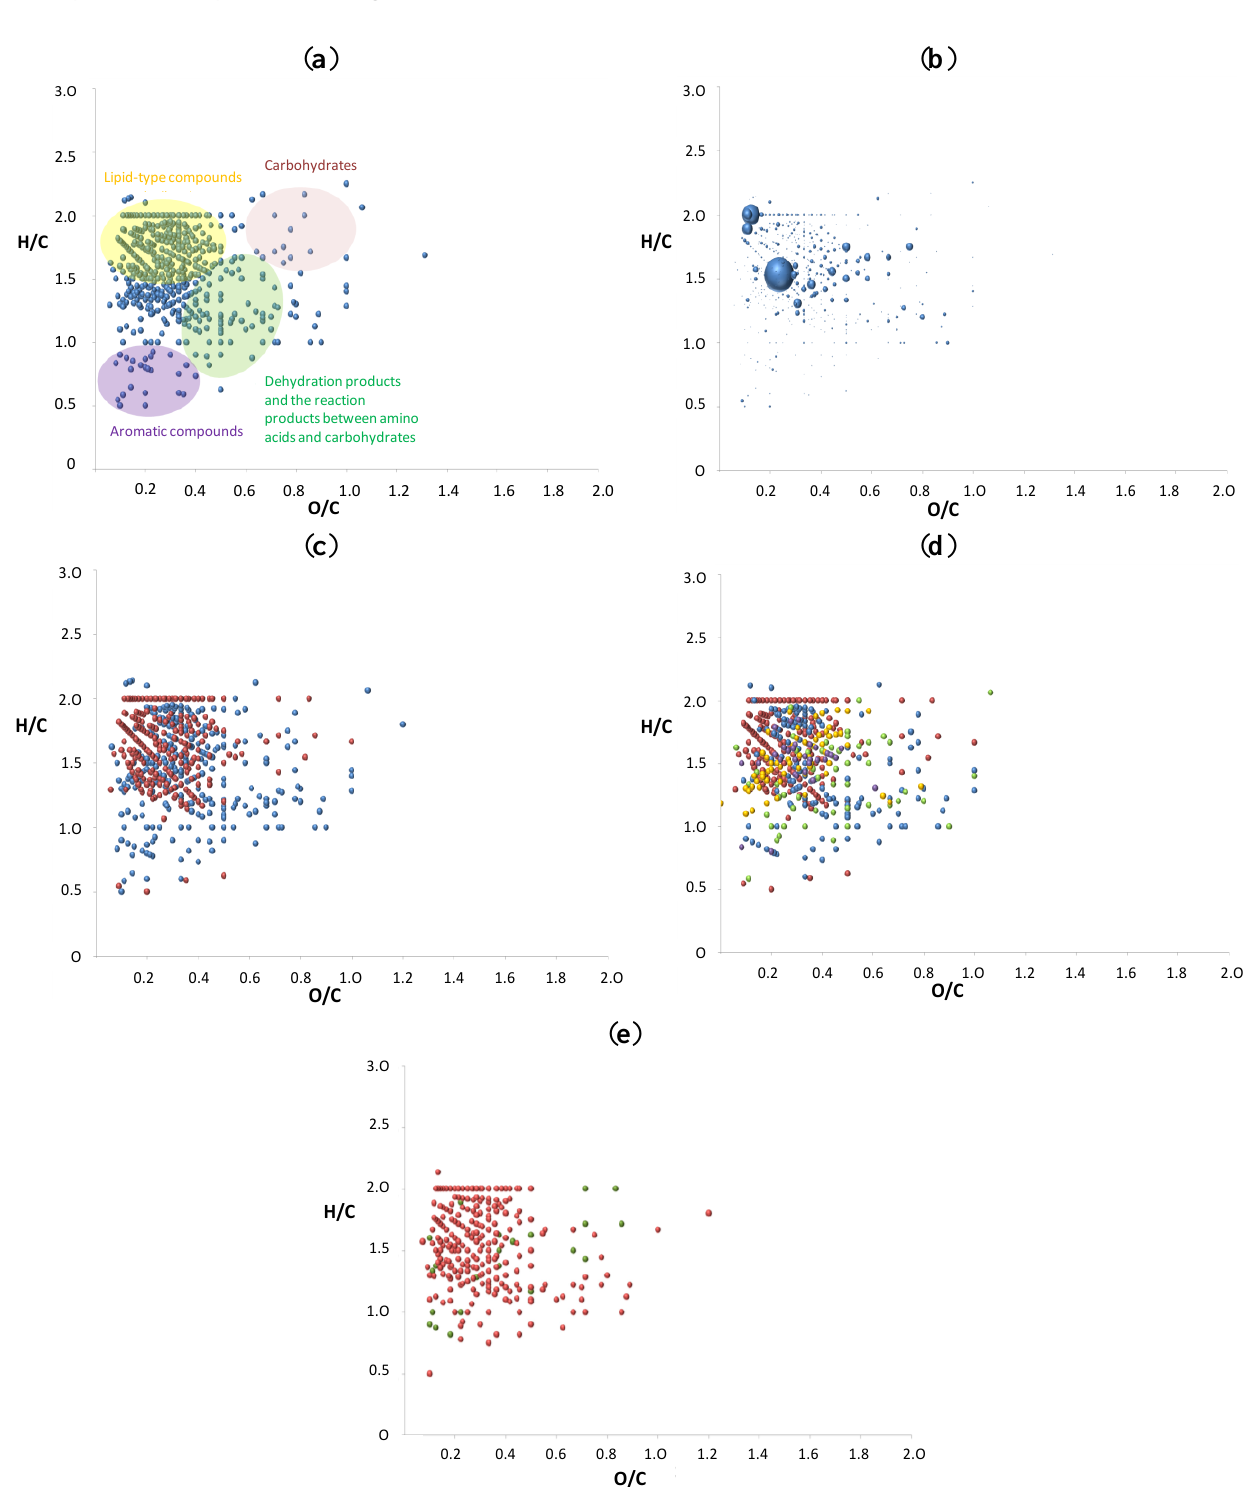
Figure 6. The van Krevelen diagrams of the reaction of sucrose with cysteine: ( a ) with colored groups of compounds; ( b ) with the intensities; ( c ) with nitrogen-free (red points) and nitrogen-containing compounds (blue points); ( d ) with nitrogen-free (red points) compounds and one nitrogen atom (blue points), two (green), three (yellow) and four (violet) nitrogen atoms; ( e ) with sulfur-free (red points) and sulfur-containing (green points) compounds in negative ion